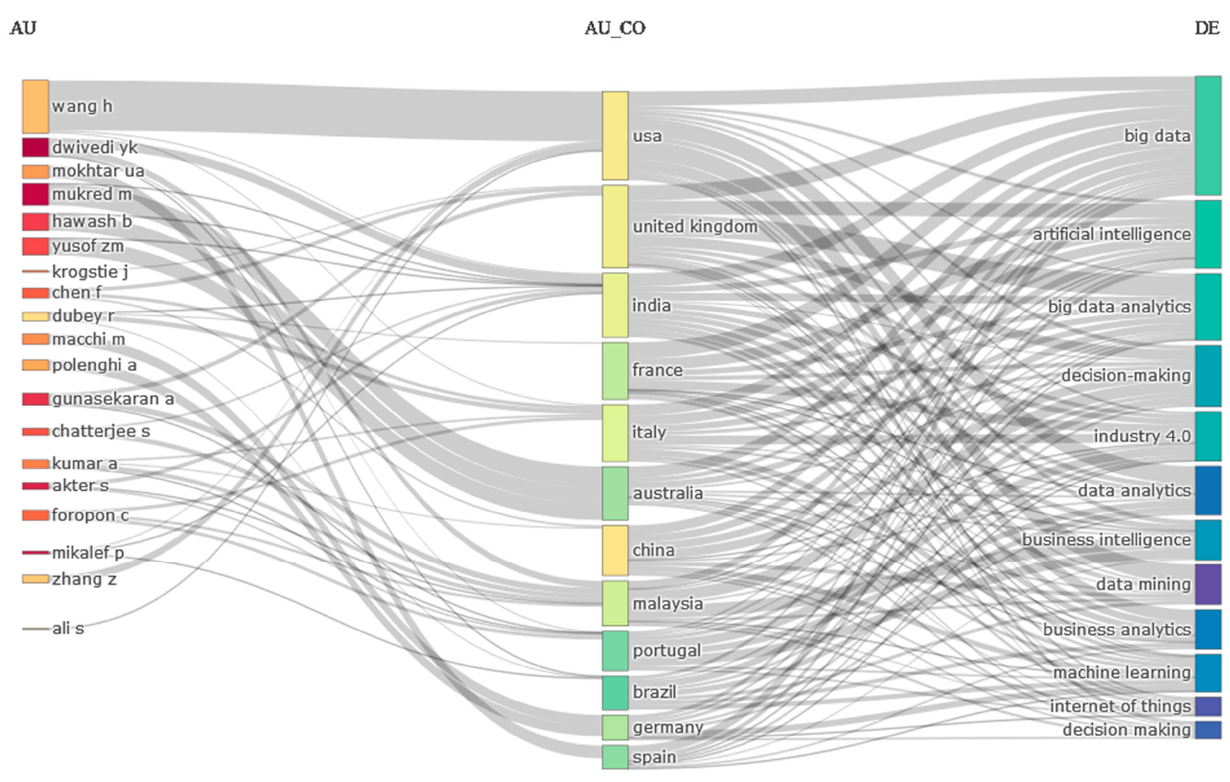
Figure 6. Three-Fields